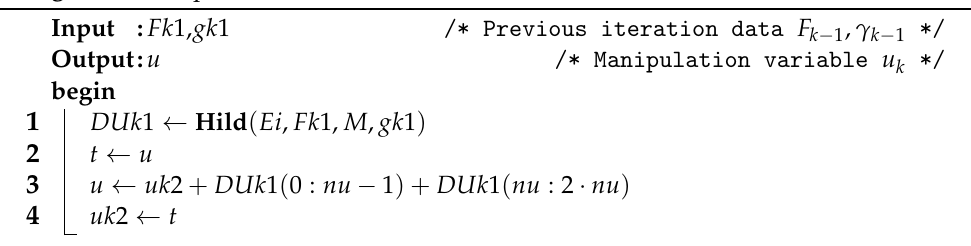
Algorithm 4: Optim+ function